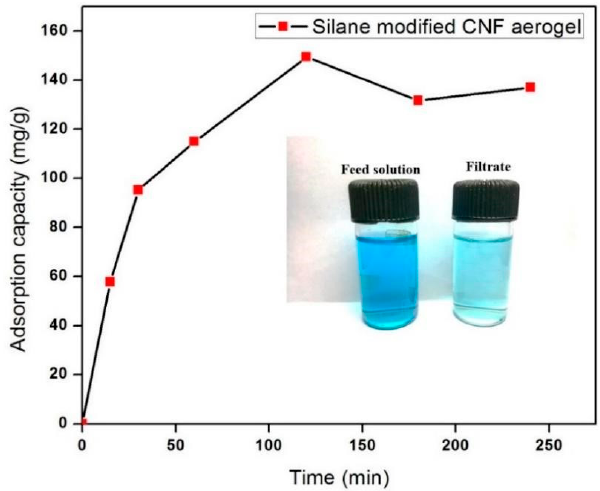
Figure 7. Adsorption capacity of silane-modified CNF aerogel against crystal violet dyes.